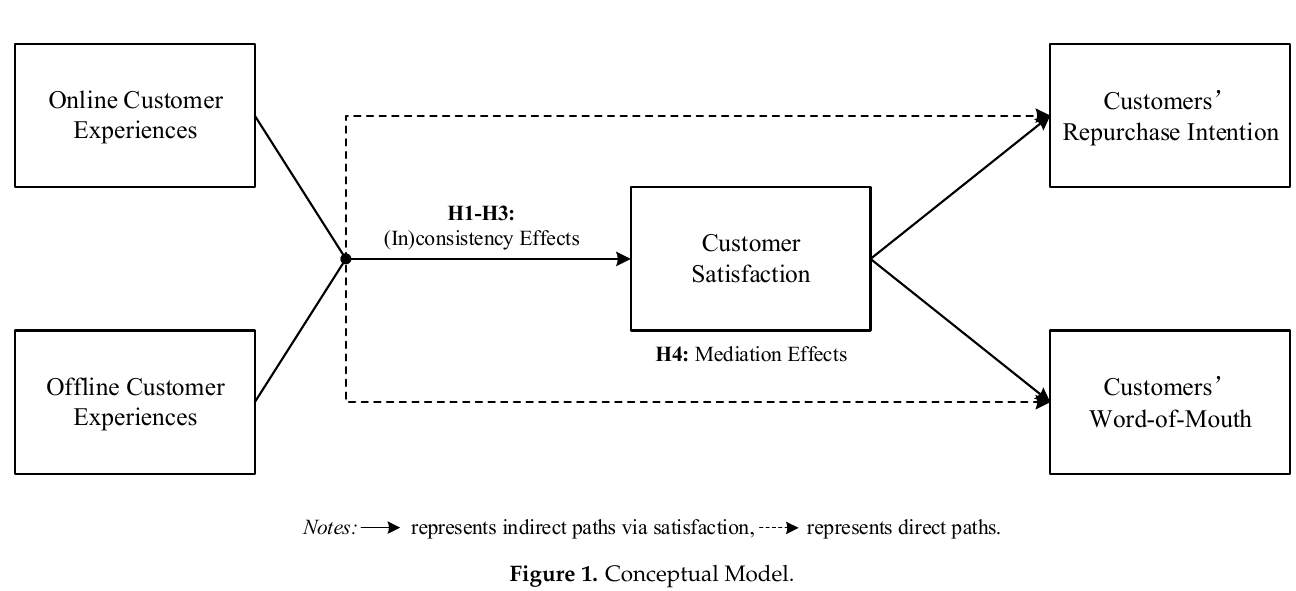
Figure 1. Conceptual Model.